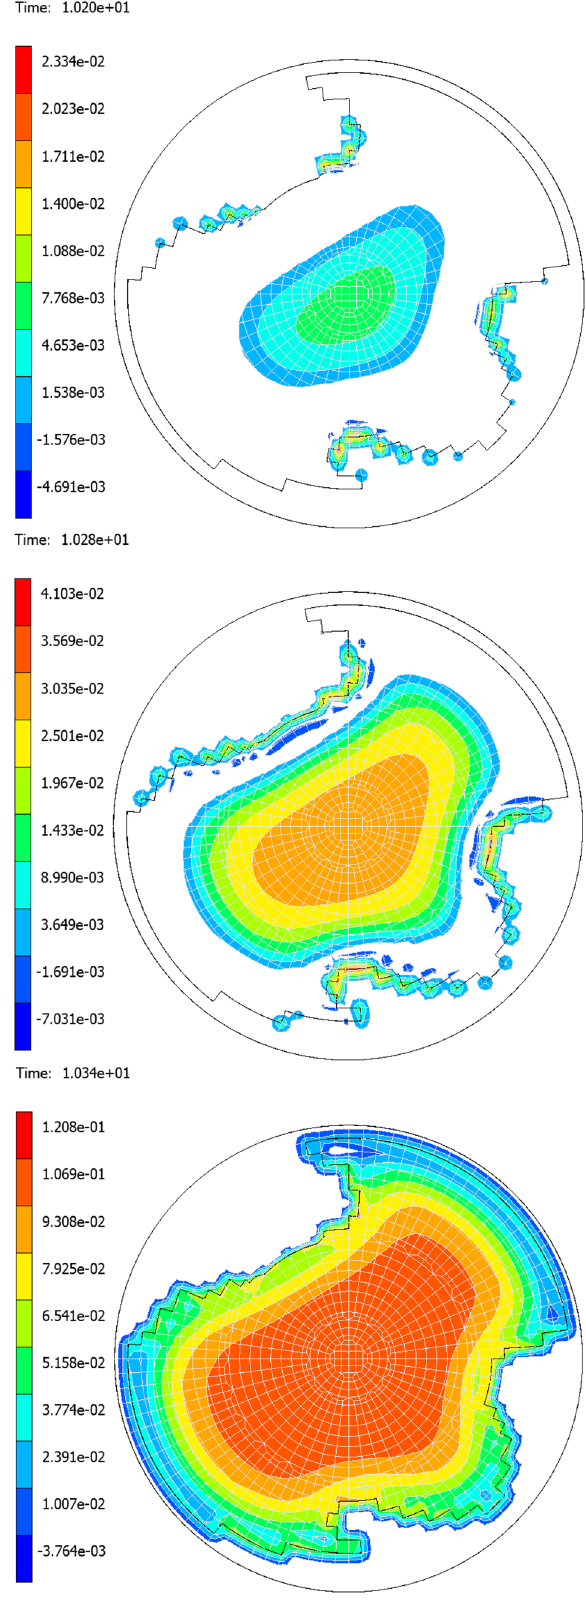
Fig. 23 Development of the adhesive contact